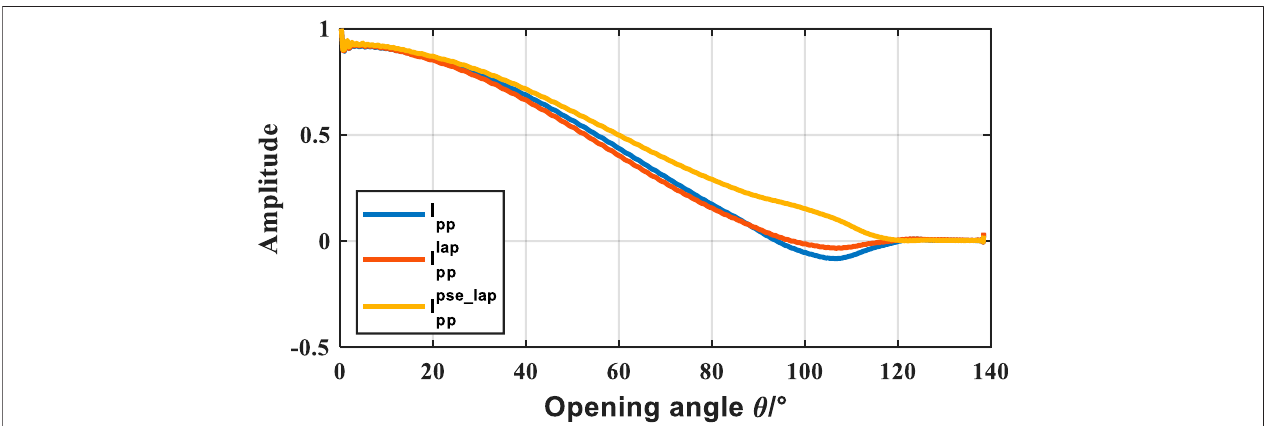
FIGURE 13 | The variation of normalized amplitude in PP images with the opening angle. Numerically, amplitude symbols change with the P-wave incident angle reaching45 + ,andtheoffsetisaround3500 minboththePPimagebythescalarimagingcondition(bluecurve)andthescalarimagingconditionwithaLaplace fi lter(red curve). In contrast, amplitude symbols are consistent in the PP image by the scalar imaging condition with a pseudo-Laplace fi lter (yellow curve).